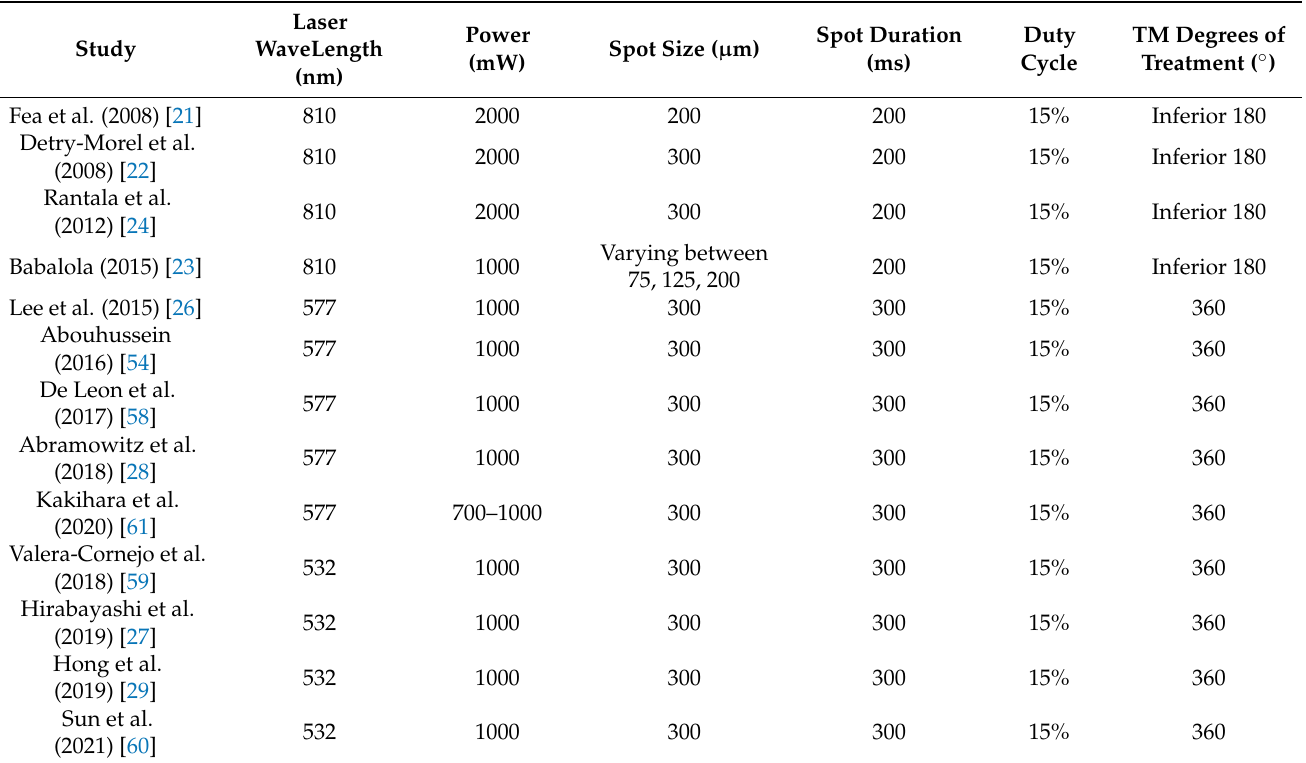
Table 1. MDLT settings in different studies. TM = Trabecular